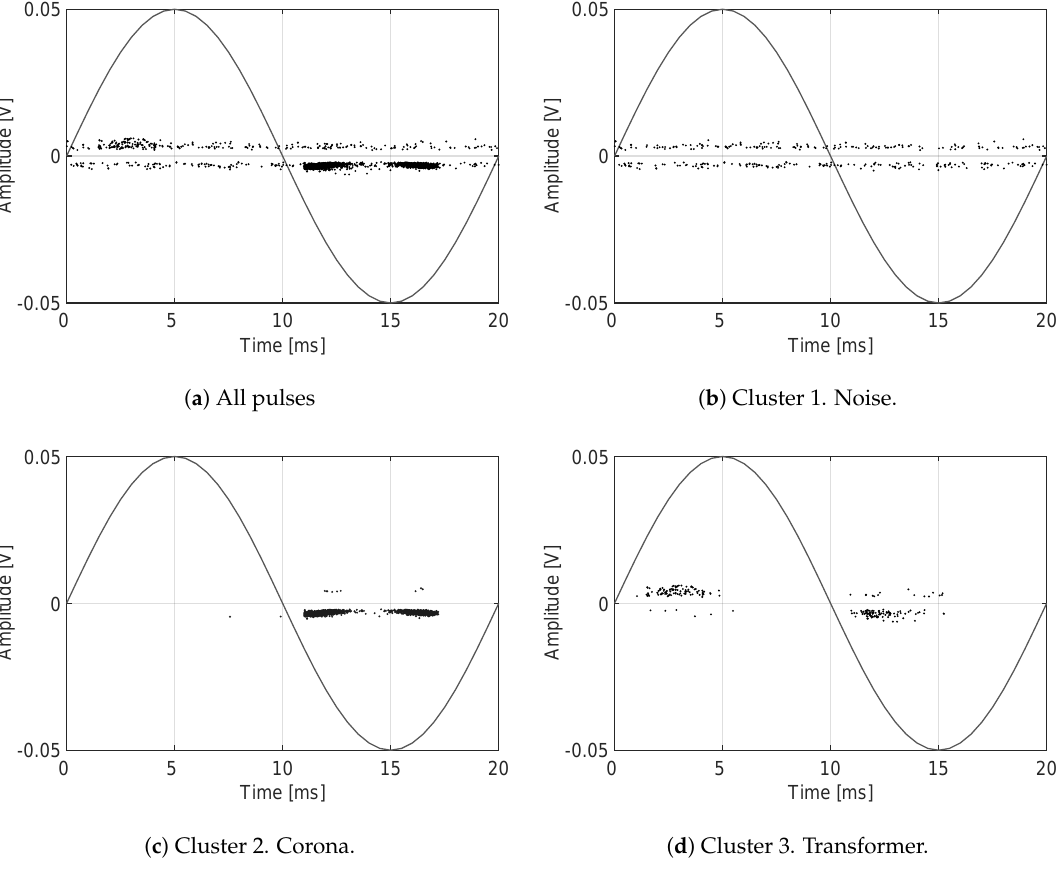
Figure 14. Phase-resolved patterns to identify the type of